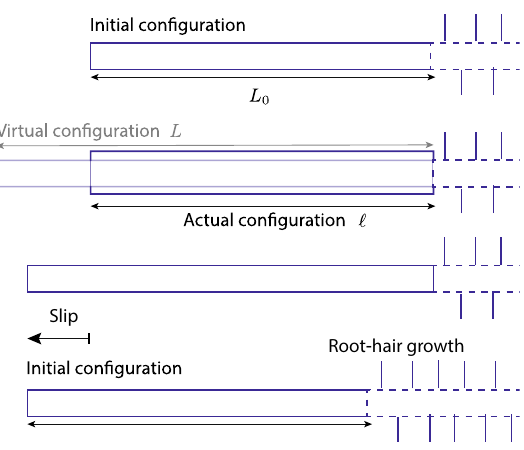
Figure 2. Different stages during stick-grow-slip without buckling. From top to bottom: Initial configuration, virtual (grown) configuration vs the actual configuration, stress release by slip, new initial configuration.